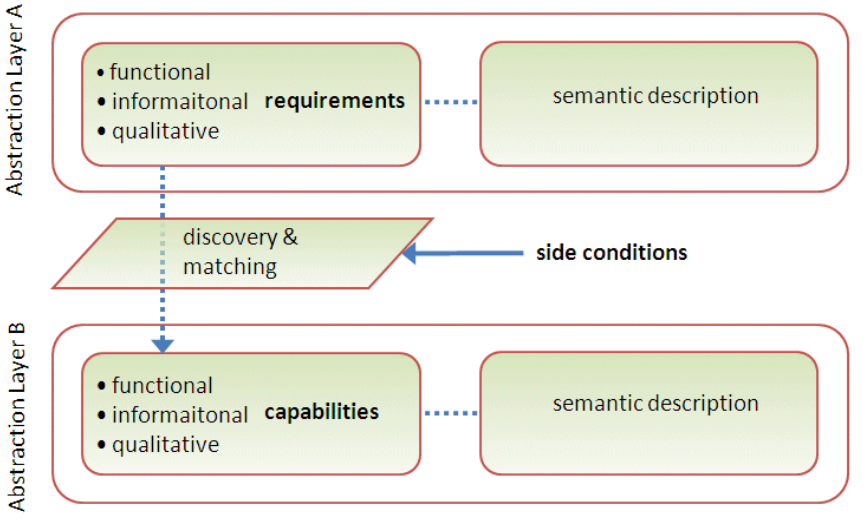
Figure 10. Mapping of requirements to capabilities (from